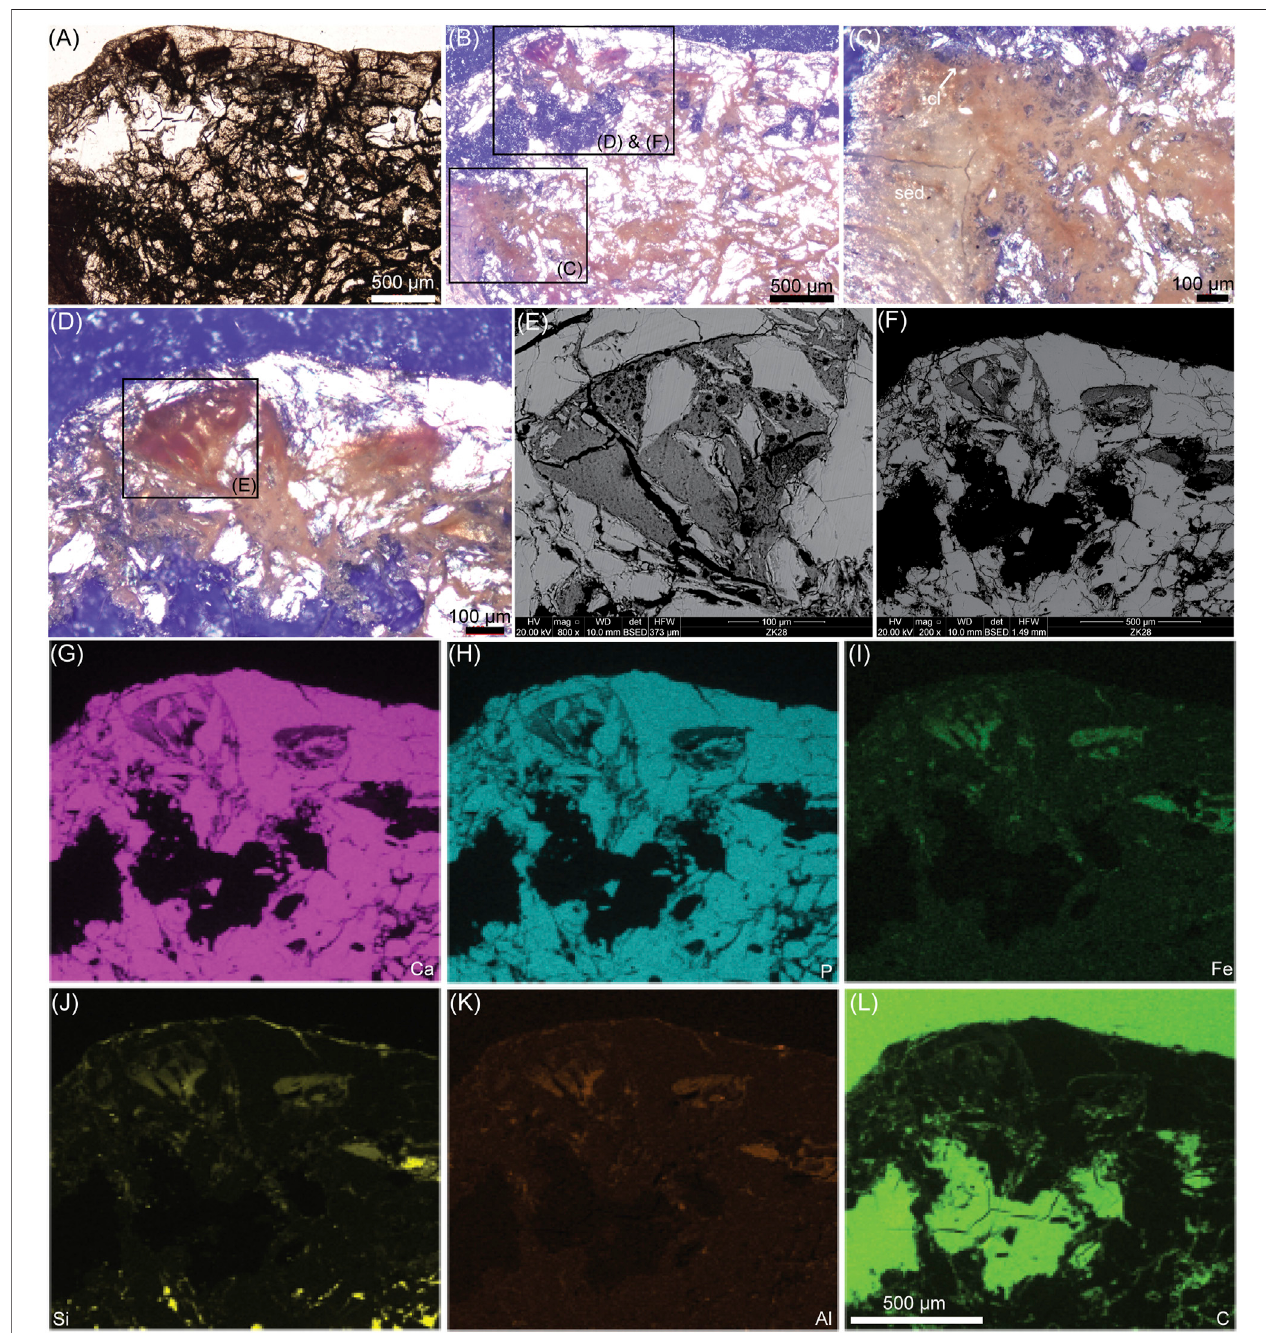
FIGURE3| Ground-sectionwithSEMandEDSanalysesoftheleftepicleidealprocessofthefurculaof Confuciusornis (IVPPV11521). (A) Photographofaground- section under transmitted light. (B) Same photograph taken under the polarized light.The entire element is fi lled withan orangey-brown fi lamentous network. (C) Close- up on that fi lamentous network, showing the chondrocyte lacunae (cl) are also fi lled with material of the same color. (D) Another close-up showing the fi lamentous network that is continuous with a darker reddish material inside a vascular space. (E) SEM image of tissues seen in a vascular space with no clearly recognizable structure. (F) SEM image of (D) . (G) – (L) are EDS mapping of the individual elements calcium (Ca), phosphorous (P), iron (Fe), silicon (Si), aluminum (Al) and carbon (C). The scale bar is the same from (G) through (L) . Additional abbreviation: sed, sediment.